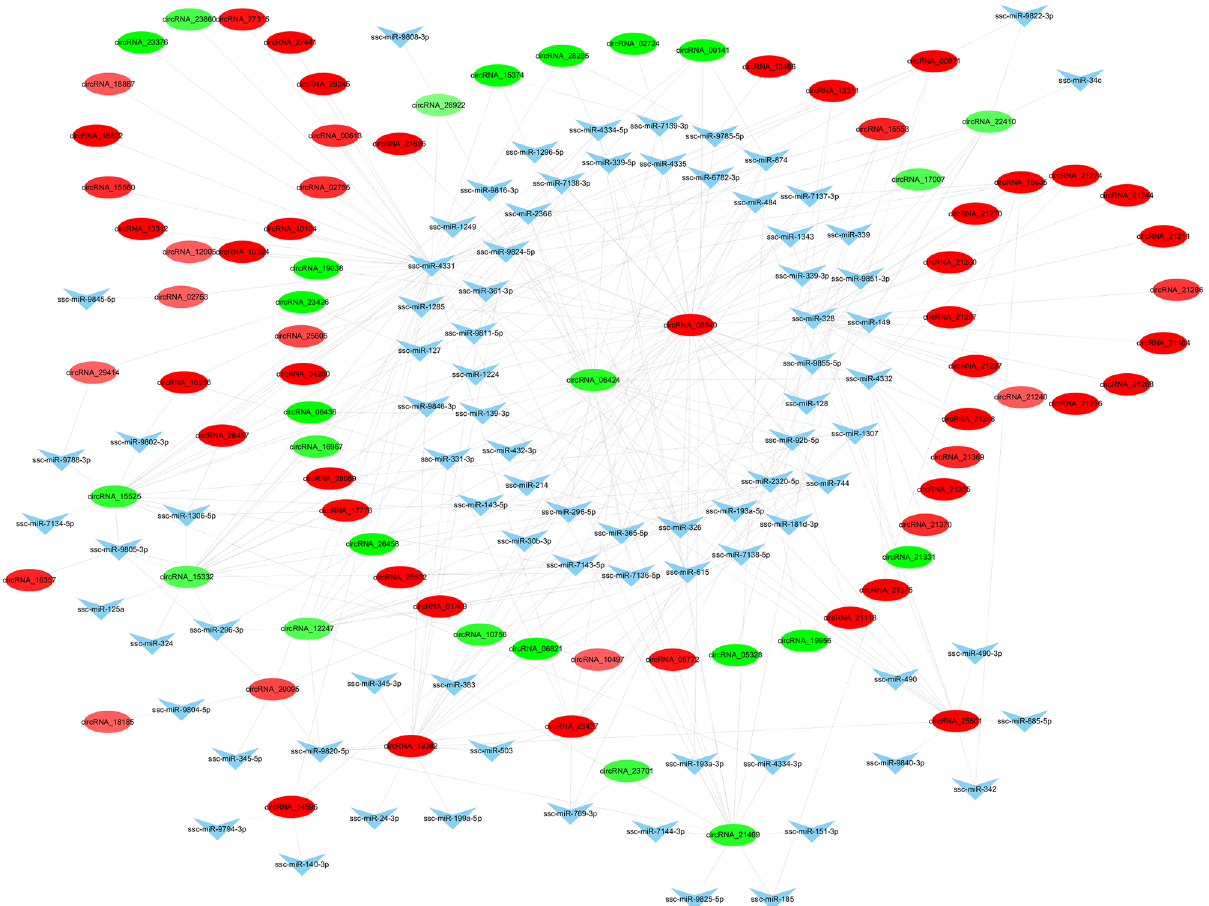
Figure 4. circRNA-miRNA interaction network. The circle represents the circRNA; triangle represents the miRNA; red represents upregulation; green represents downregulation; blue represents no difference.